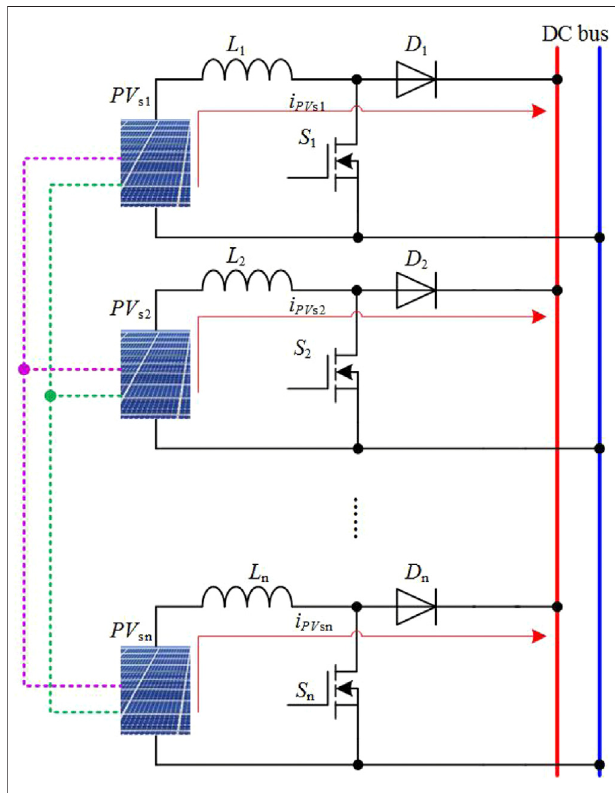
FIGURE 4 | PV string connection circuit schematic